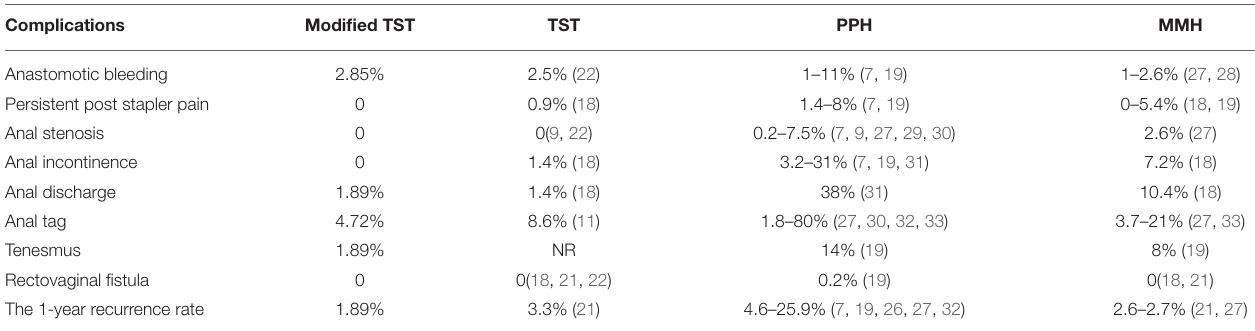
TABLE 4 | The incidence of postoperative complications of different surgical